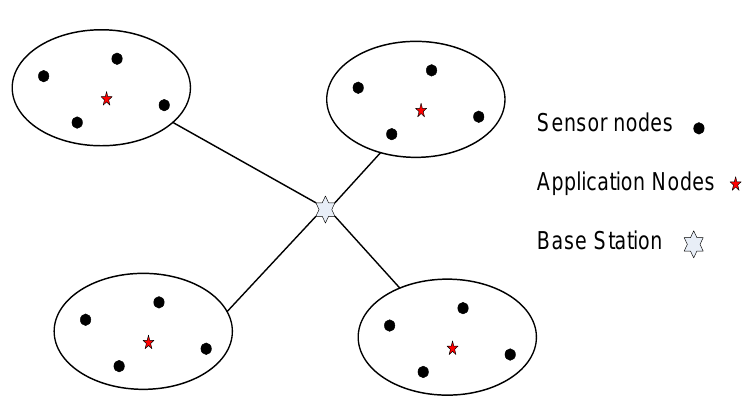
Figure 5. A two tier architecture of